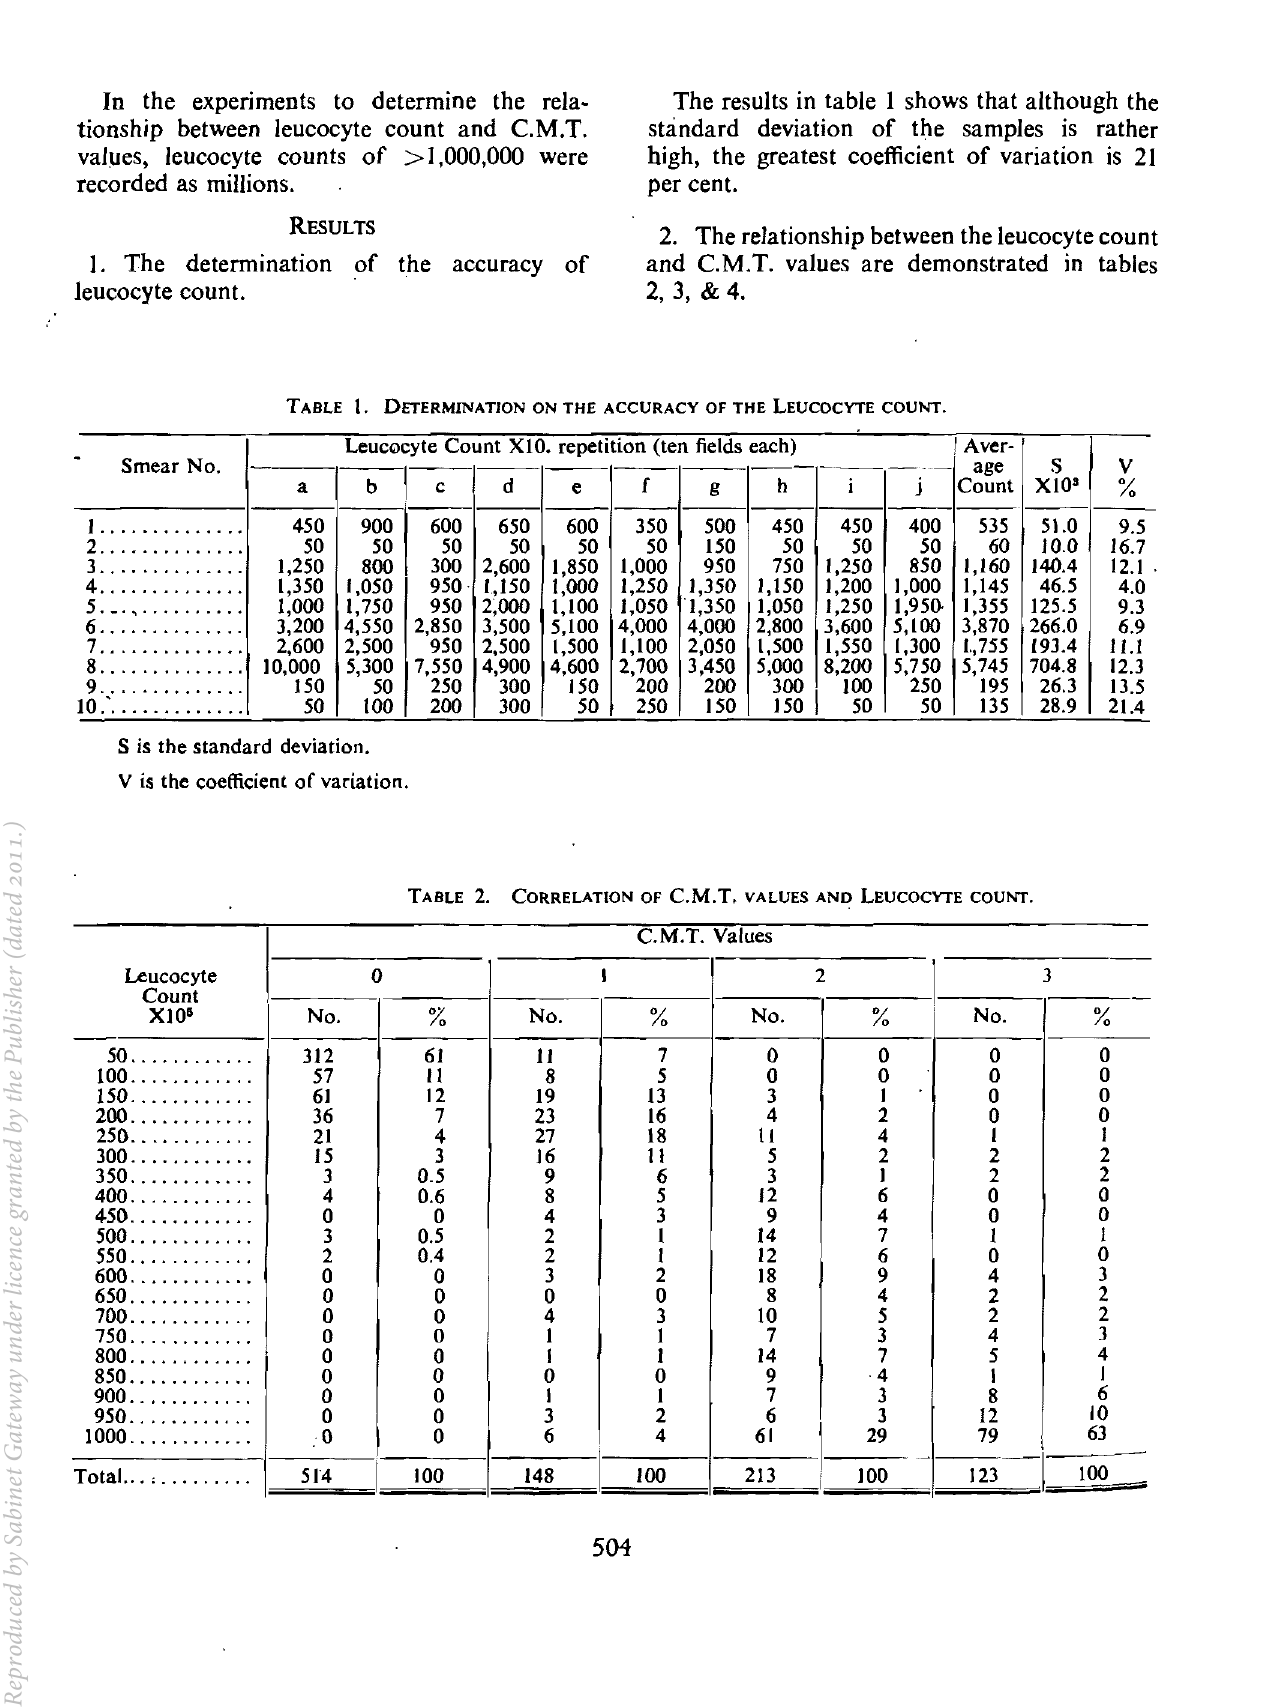
TABLE 1. DETERMINATION ON THE ACCURACY OF THE LEUCOCYTE COUNT.